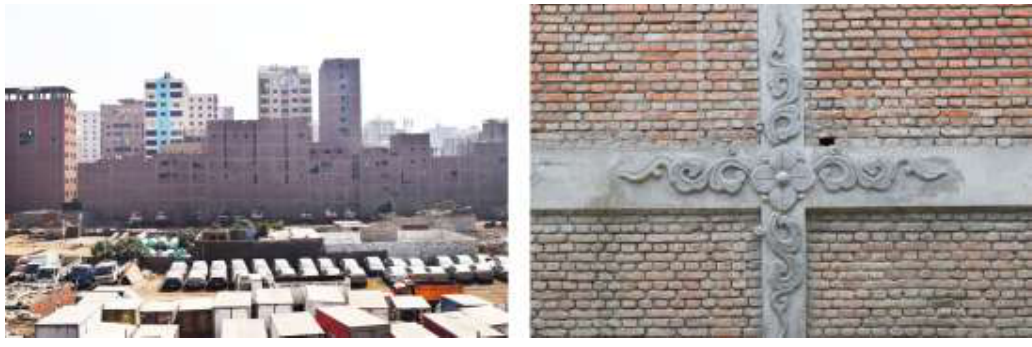
Figure 10 Informal housing skyline Figure 11 Example of decorative concrete cast